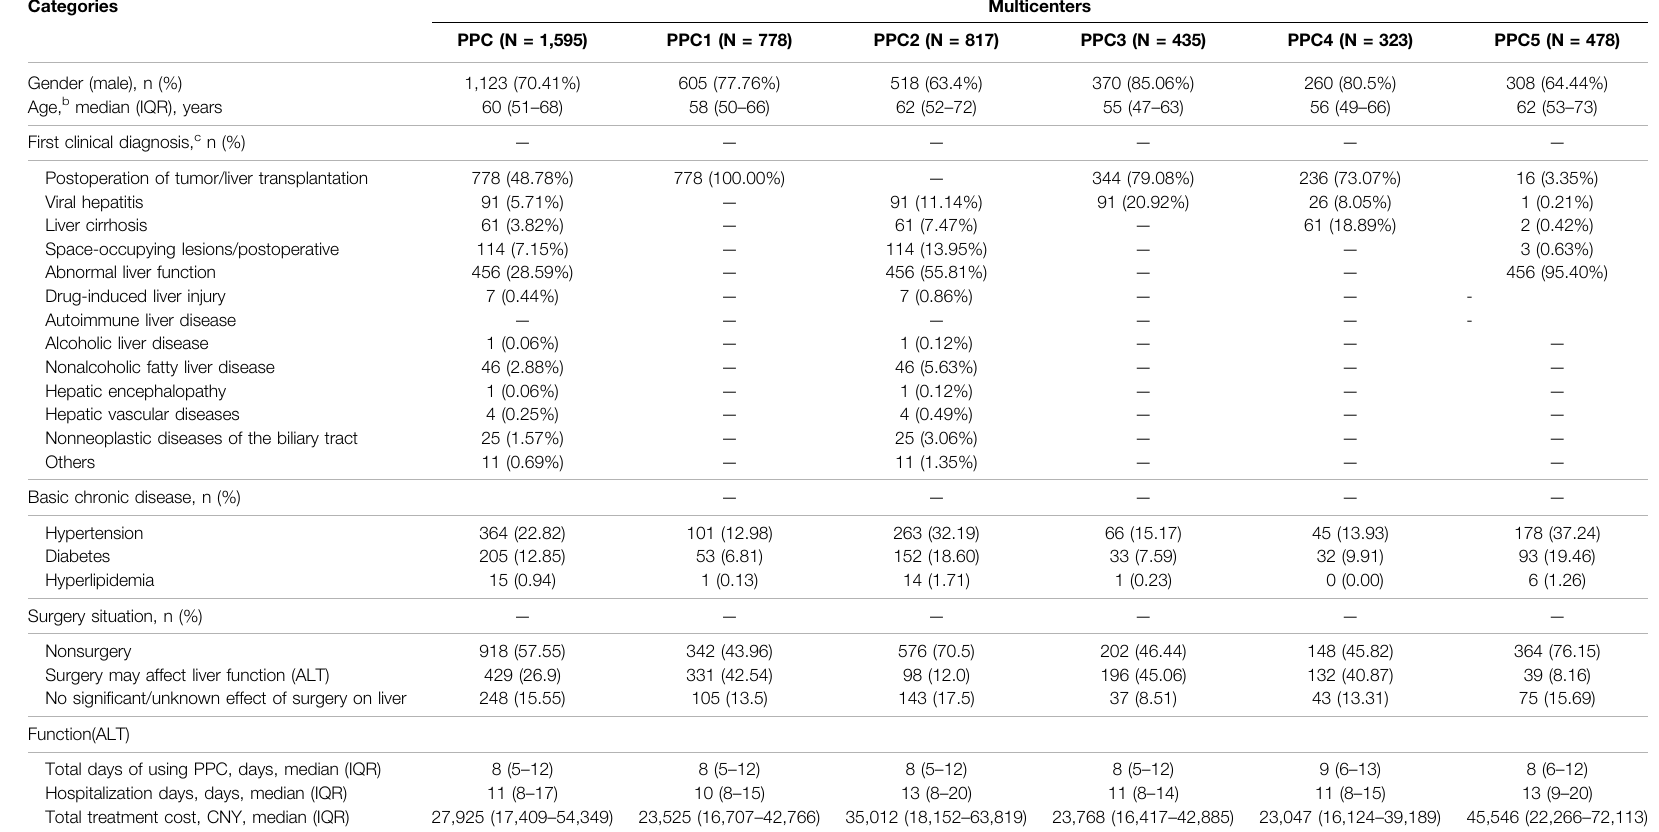
TABLE 2 | Baseline information in phase